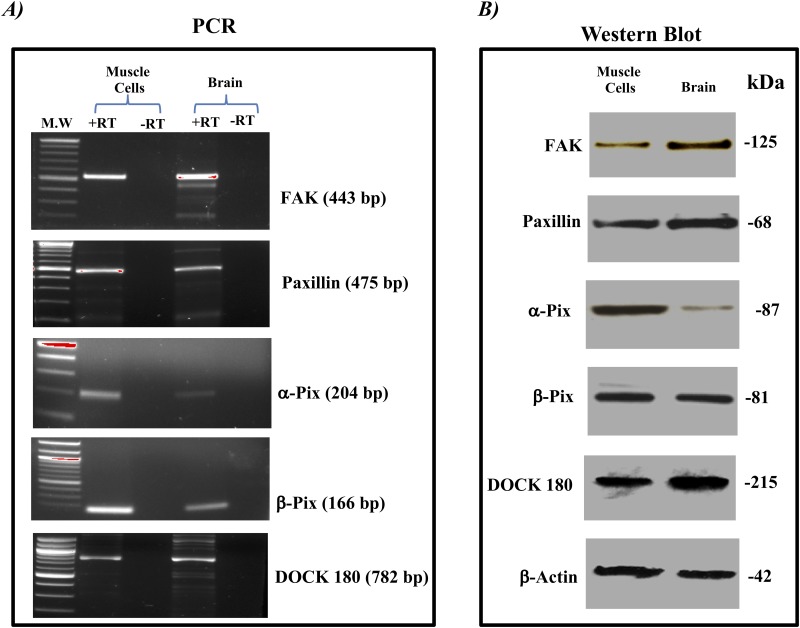
Expression of focal adhesion kinase (FAK), paxillin, Cool2/p21-activated kinase (PAK) interacting exchange factor alpha (Cool2/α-Pix), Cool1/ p21-activated kinase (PAK) interacting exchange factor beta (Cool1/β-Pix) and DOCK 180 in smooth muscle cells.A: Total RNA was isolated from cultured gastric smooth muscle cells and brain homogenates as control were reverse transcribed (RT). PCR products of expected-size FAK (443 bp), paxillin (475 bp), Cool2/α-Pix (204 bp), Cool1/β-Pix (166 bp), and DOCK 180 (782 bp) were obtained in muscle cells and in brain homogenates. B: Western blot analysis showed that corresponding proteins with appropriate molecular weights were obtained in muscle cells and in brain homogenates (40 μg protein). MW, molecular weight.